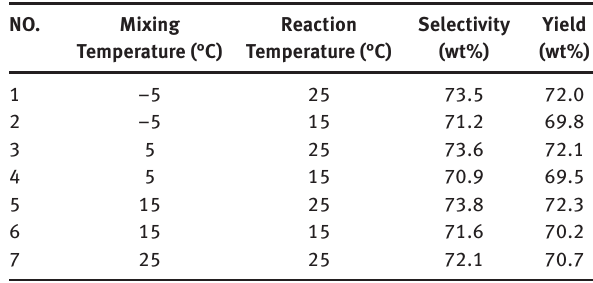
Table 3: The relationship between temperature and the results of the acylation reaction of 2-MN.